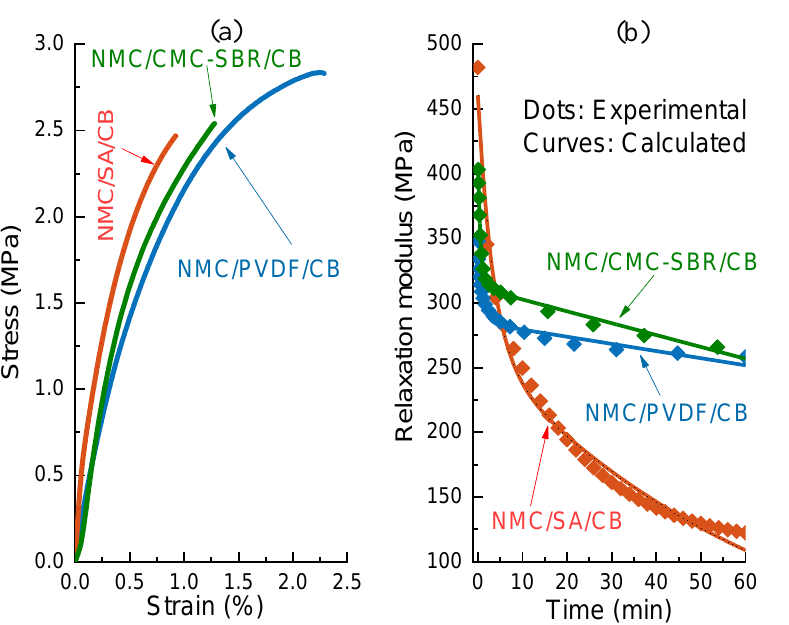
Figure 2. ( a ) Tensile stress–strain curves and ( b ) evolution of relaxation Young’s modulus for LiNi 0.5 Mn 0.3 Co 0.2 O 2 (NMC)-based composite with different binders. CMC-SBR, carboxymethyl cellulose/styrene-butadiene rubber; CB, carbon black; PVDF, poly (vinylidene fluoride); SA, sodium alginate.